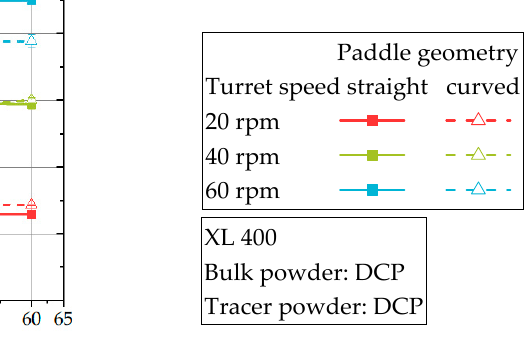
( b ) Figure 12. Residence time distribution E t ( a ) and normalized residence time distribution E θ ( b ) of DCP for turret and paddle speeds of 20 rpm on different tablet presses. It is hypothesized that the powder that enters the metering chamber during the backdosing remains inside the metering chamber for a considerable amount of time before it is eventually transported back into the feeding chamber. As discussed before, these prolonged residence times can have a deteriorating effect on the powder properties and thus, are to be avoided. Therefore, in terms of RTDs, single chamber feed frames are desirable to avoid the separation of material fractions which can result in high differences in residence time and thus, inhomogeneity of tablet properties. These